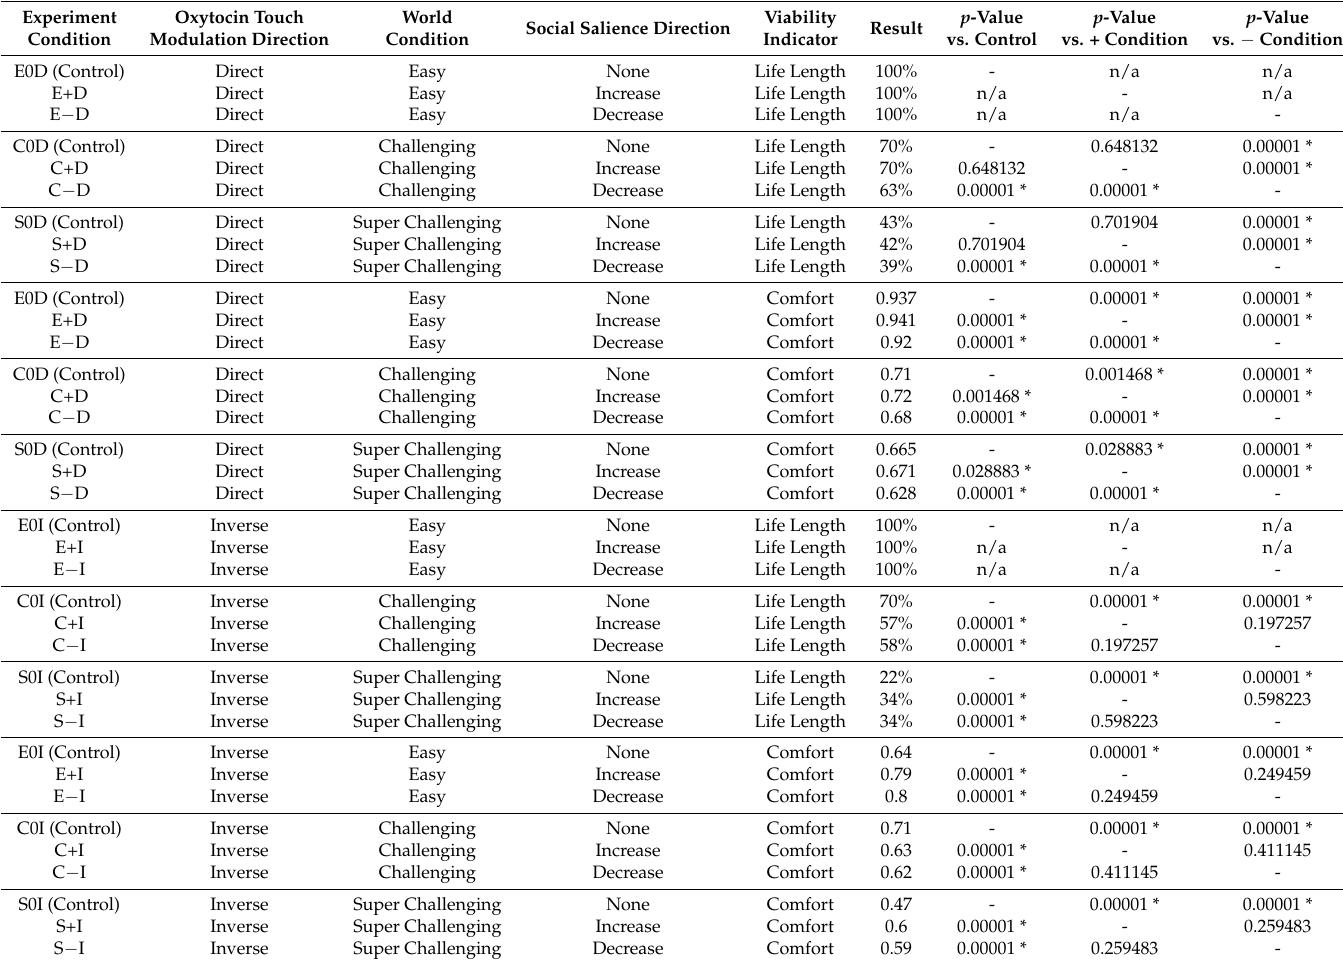
Table 7. Summary of results for Experiment 2, including p -values for all conditions. The p -values reported are for aggregated results across all touchingIntensity values. * indicates statistical significance. 0 denotes Control group with no oxytocin effects, + are Increased Social Salience groups, and − are Decreased Social Salience groups. D denotes Direct modulation of touchingIntensity , and I indicates Inverse modulation of touchingIntensity